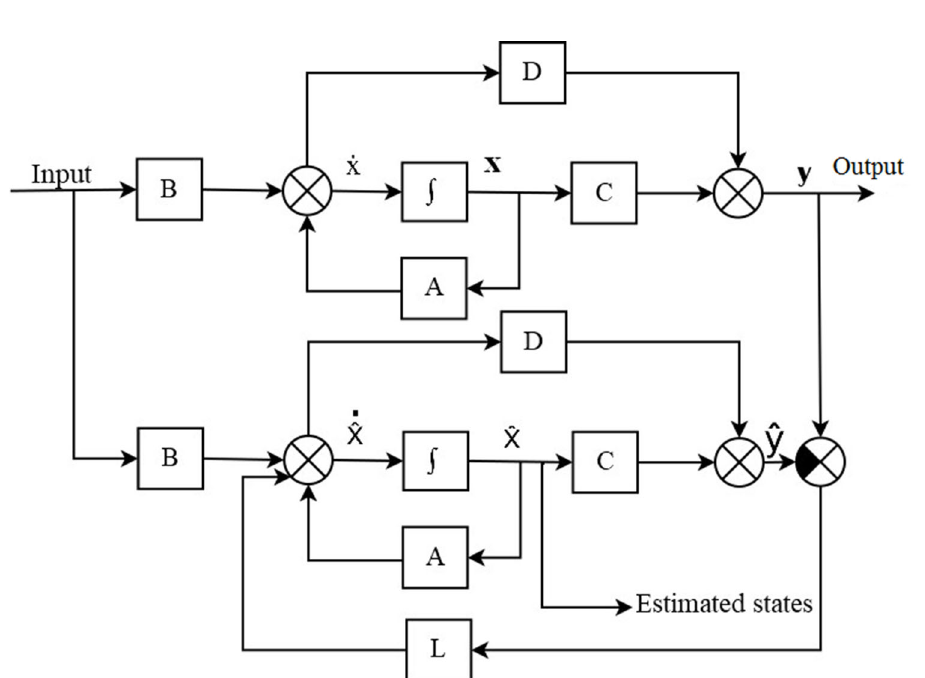
Figure 5. Block diagram of the Luenberger Observer used for estimation of pitch and